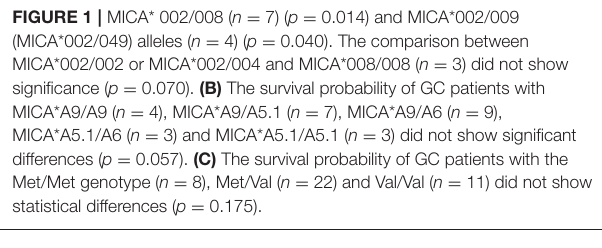
FIGURE 1 | MICA* 002/008 ( n = 7) ( p = 0.014) and MICA*002/009 (MICA*002/049) alleles ( n = 4) ( p = 0.040). The comparison between MICA*002/002 or MICA*002/004 and MICA*008/008 ( n = 3) did not show significance ( p = 0.070). (B) The survival probability of GC patients with MICA*A9/A9 ( n = 4), MICA*A9/A5.1 ( n = 7), MICA*A9/A6 ( n = 9), MICA*A5.1/A6 ( n = 3) and MICA*A5.1/A5.1 ( n = 3) did not show significant differences ( p = 0.057). (C) The survival probability of GC patients with the Met/Met genotype ( n = 8), Met/Val ( n = 22) and Val/Val ( n = 11) did not show statistical differences ( p = 0.175).